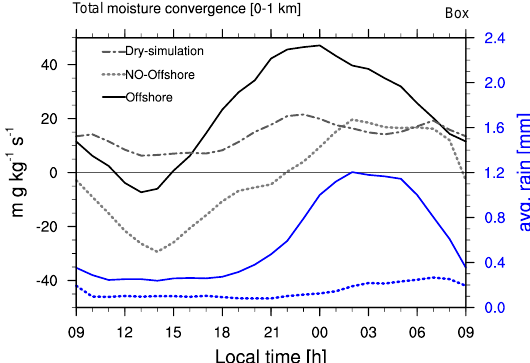
Figure 8. Total moisture convergence (VIMFC, mgkg − 1 s − 1 ), ver- tically integrated between surface and 1km height (first 11 model levels), for the red box region shown in Fig. 7a (black lines). Area of the box is 290048km 2 (88 × 206 grid points). The diurnal area- averaged rainfall for offshore and no-offshore days are shown by the solid and dotted blue lines